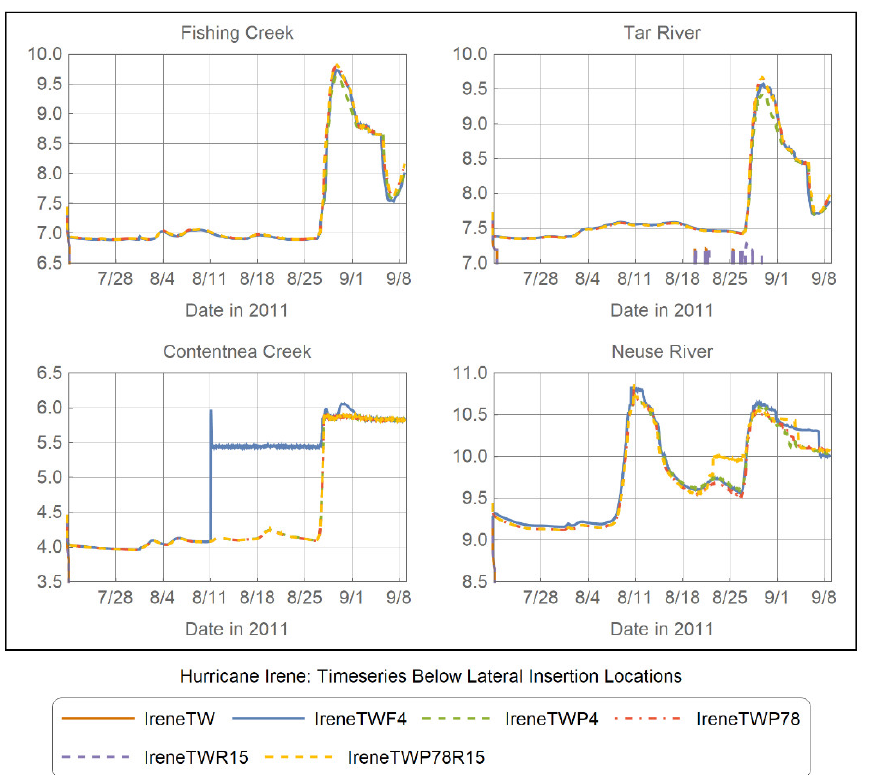
Figure 12. Hydrographs (water surface elevation in meters above MSL) located just below the NWM insertion points on each of the four main rivers for the simulations given in Table 3.